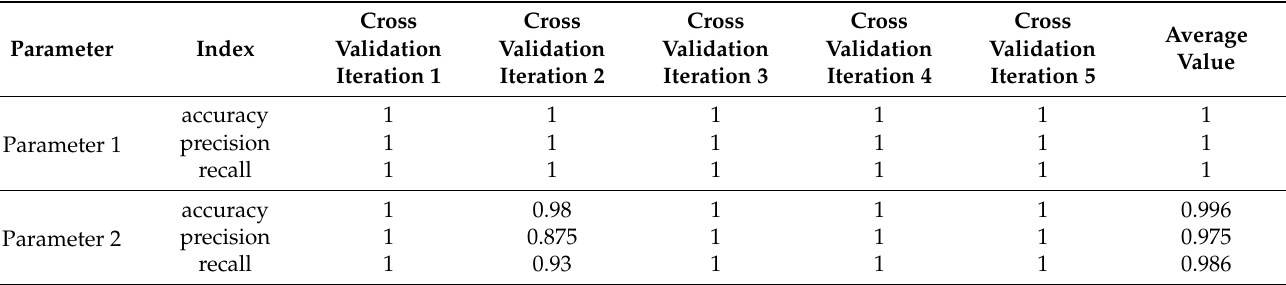
Table 3. Values of the selected parameters in different data sets. Table 4. Index of the classification using a single